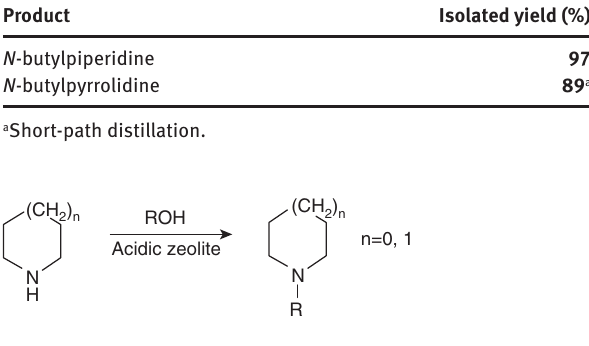
Scheme 5: Alkylation of piperidine and